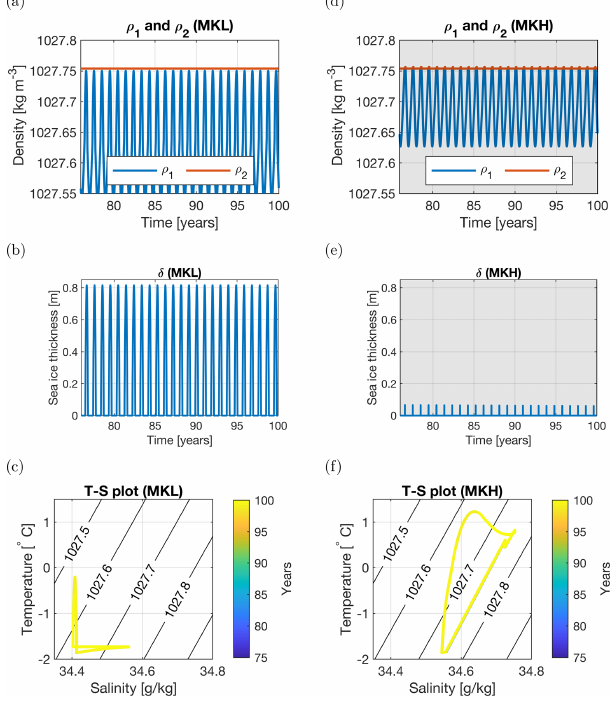
Figure 6. Years 76–100 for the MKL ( a–c ; K S = 1 . 375 × 10 − 6 ms − 1 ) and MKH ( d–f ; K S = 2 × 10 − 6 ms − 1 ) cases. (a, d) Density of the surface (blue) and subsurface (red) layer. (b, e) Sea-ice thickness. (c, f) T – S plot of the temperature and salin- ity of the surface layer. The coloring of the curves represents time, ranging from year 76 (blue) to year 100 (yellow). Only the last year is visible, because previous years have the same yearly cycle. The direction in time is the same as in Fig. 5. The black contour lines represent the density (in kgm − 3 ). Shading represents polynya years.